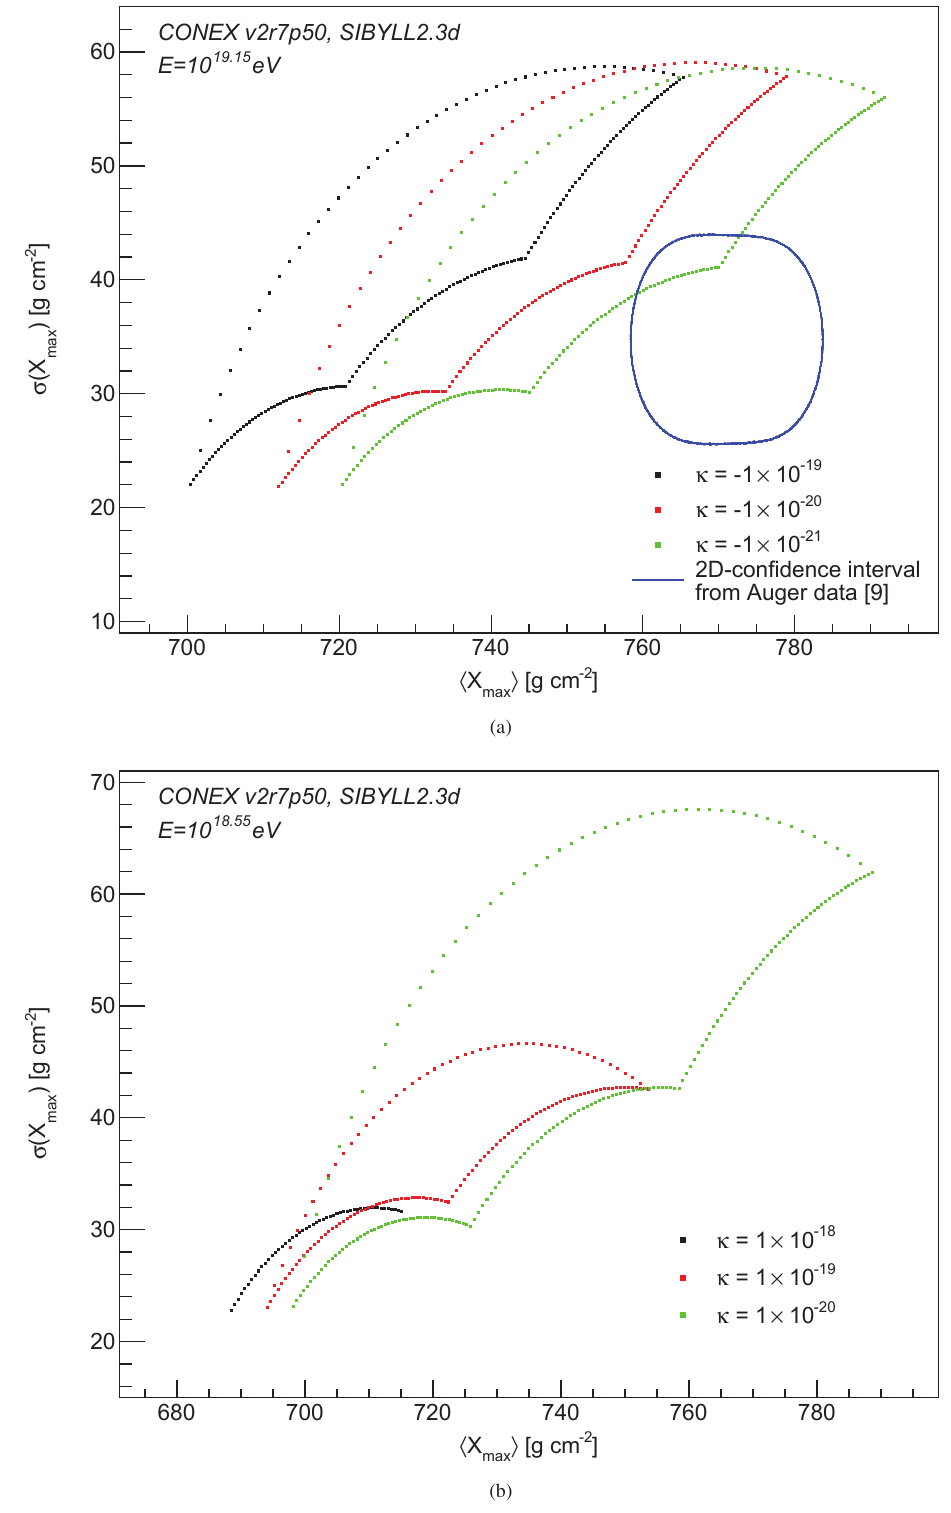
Figure 2. Comparison of combinations of (cid:3) X max (cid:4) and σ ( X max ) derived by simulations using CONEX and the hadronic interaction model SIBYLL 2.3d. For a given κ , the corresponding “umbrella” covers all values allowed by arbitrary combinations of these primaries. In (a), the case κ < 0 is shown, for di ff erent values of κ < 0 and a primary energy of 10 19 . 15 eV. In addition, the two-dimensional confidence interval given by measurements from the Pierre Auger Observatory [20] is included. In (b), the case κ > 0 is shown, for di ff erent values of κ > 0 and a primary energy of 10 18 . 55 eV. Note that in this case, combinations with particles above the VCh radiation threshold are